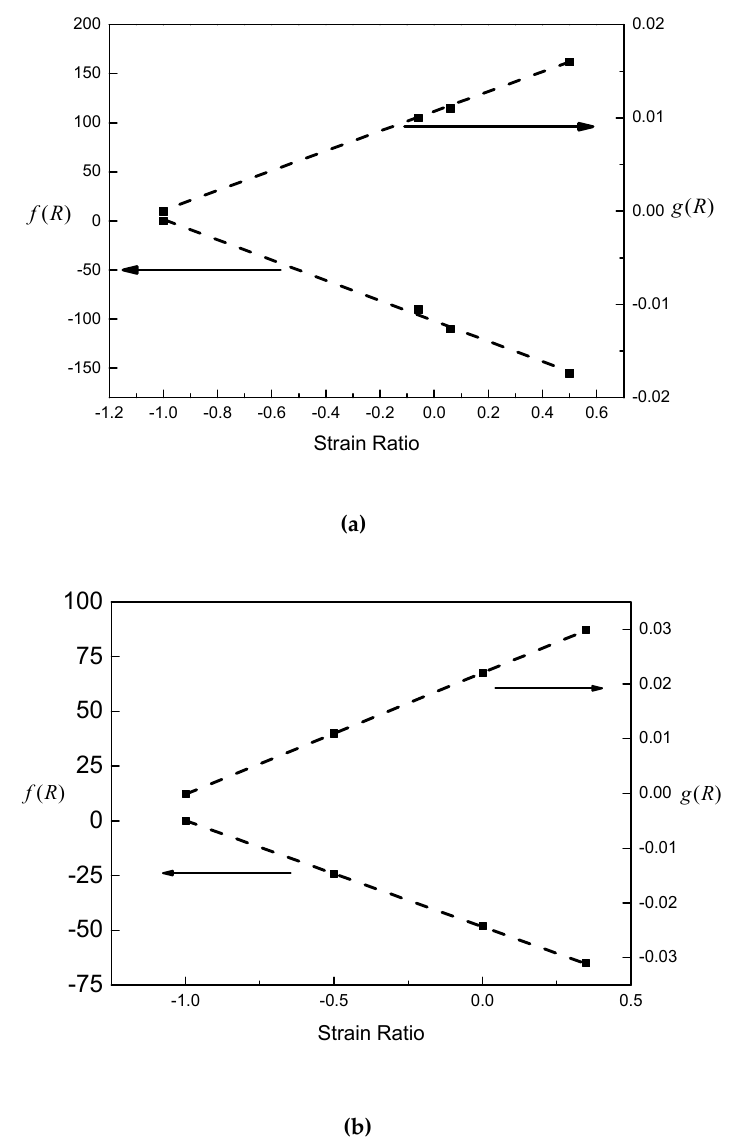
Figure 9. Relationship between correction value and strain ratio of ( a ) 2124-T851 aluminum alloy and ( b ) epoxy resin.